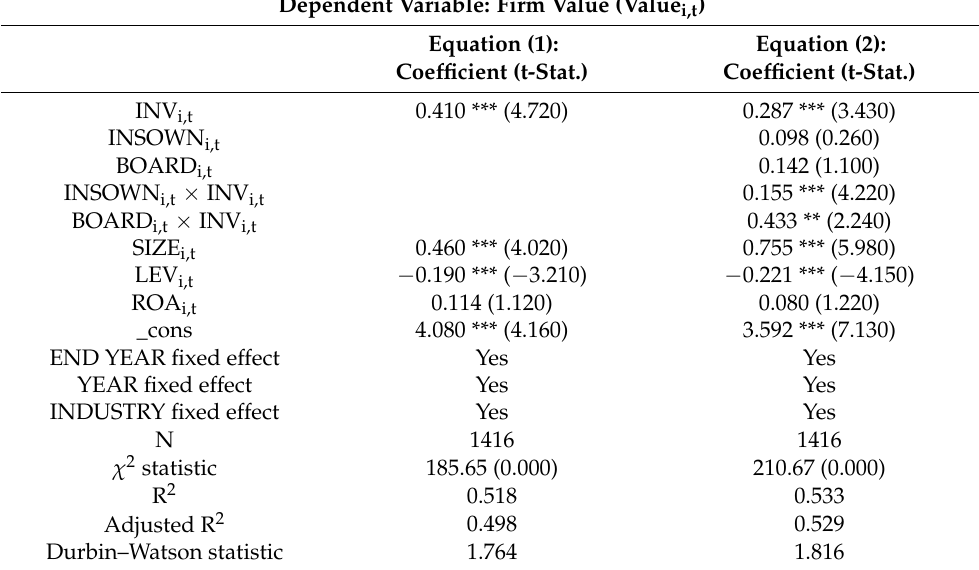
Table 5. Robust regression for the impact of investment efficiency, institutional ownership, and board independence on firm value.